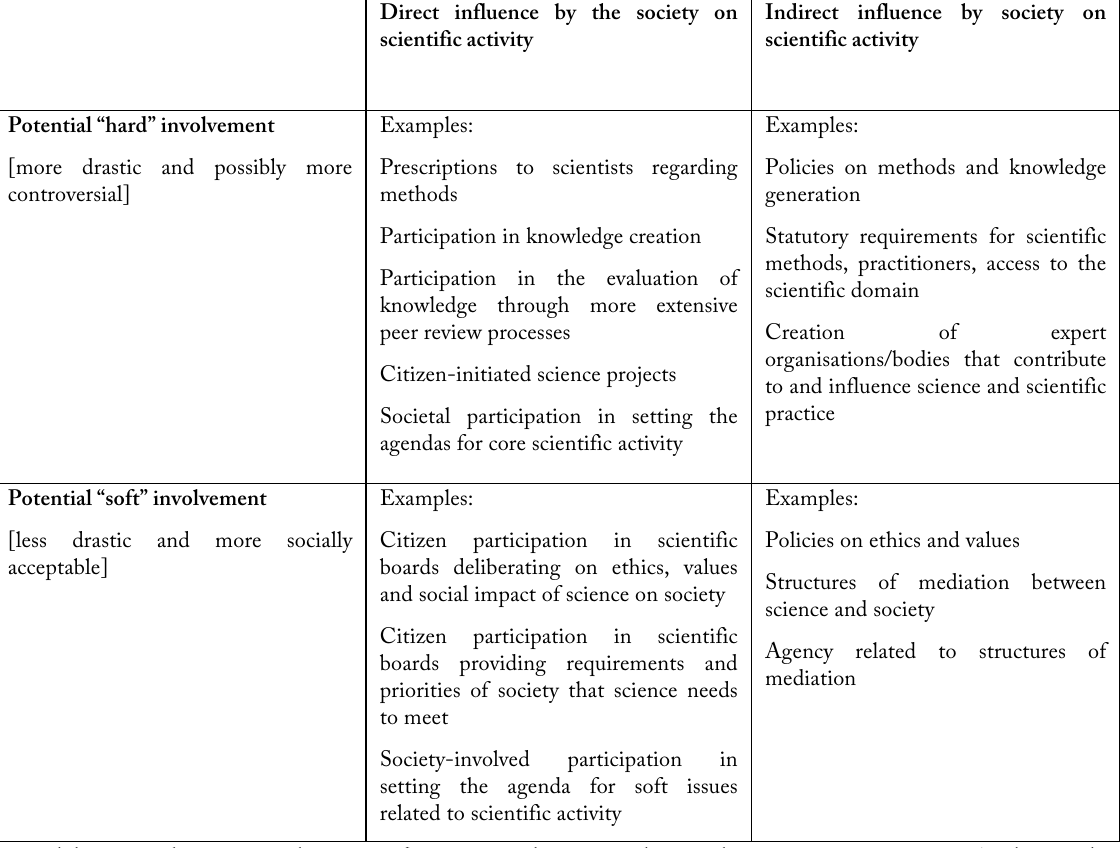
Table 1: Schematized view of potential societal involvement in science (Adopted and expanded on the basis of the basic categories of Kleinman,